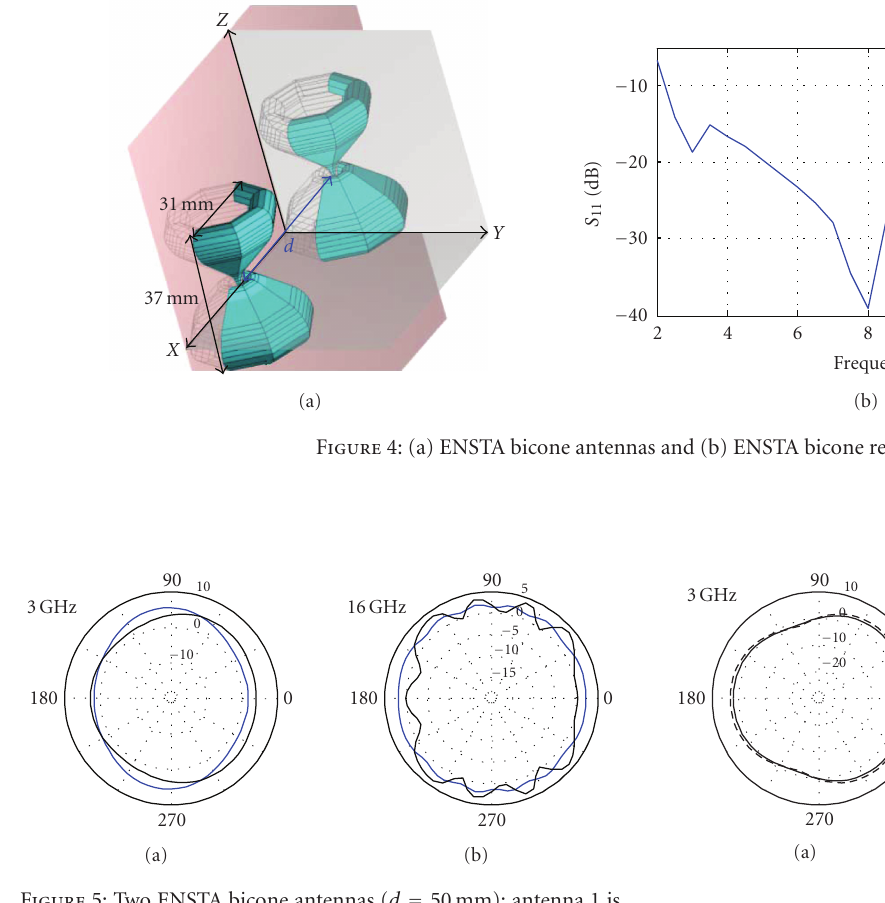
Figure 5: Two ENSTA bicone antennas ( d = 50 mm): antenna 1 is excited; antenna 2 is 50Ohms loaded. Simulated expected radiation pattern (black line) and point source approximation (blue line).